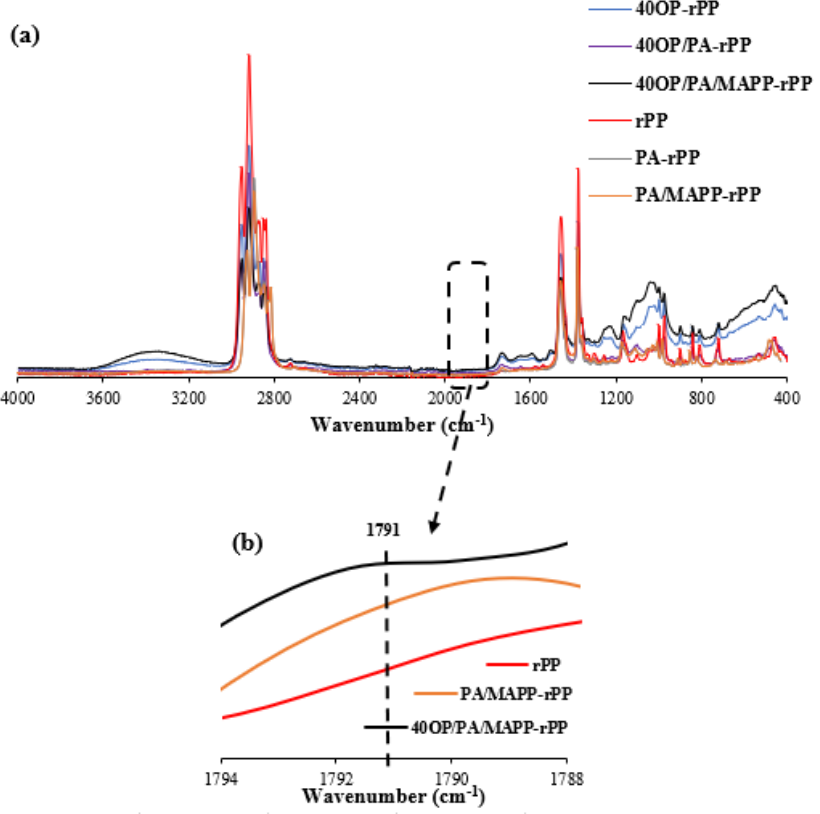
Figure 16. ( a ) FT−IR Spectra of composites loaded with 40 wt% OP with and without additives; ( b ) rPP, PA/MAPP-rPP and 40OP/PA/MAPP-rPP detailed in region between 1788–1794 cm −1 .